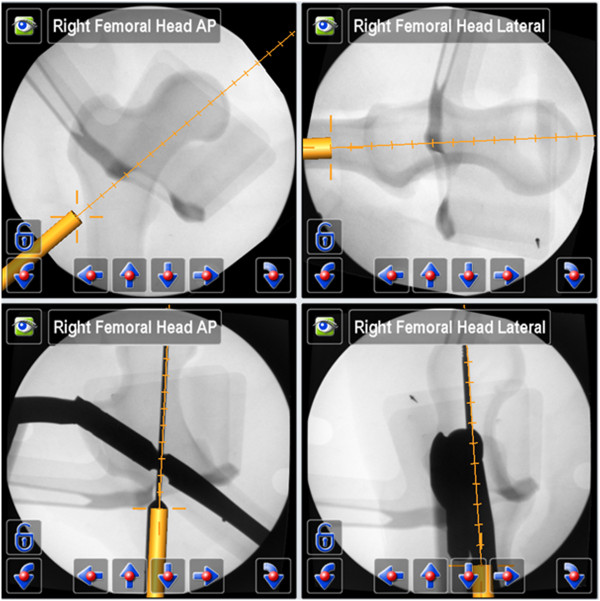
Navigation steps 2 and 3 → Orientation of the intramedullary nail for ideal placement of a guide wire for the femoral neck screw (above), virtual projection with guide wire (below).